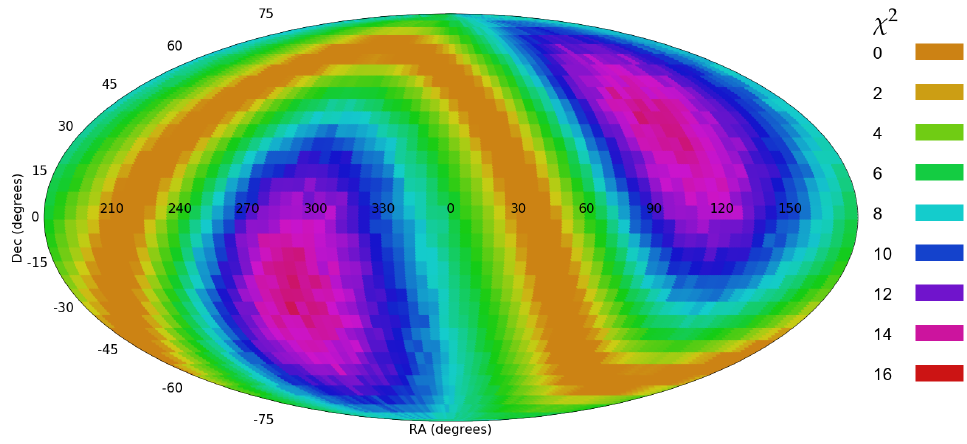
Figure 17. The χ 2 probability of a dipole axis such that the galaxies are assigned with random spin directions, except for a certain sky